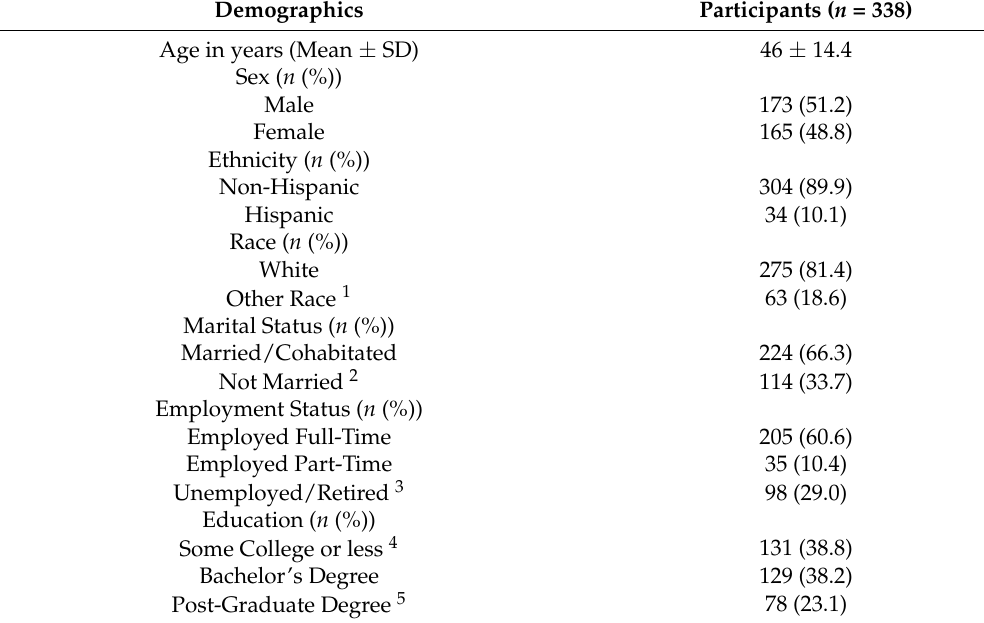
Table 1. Participant